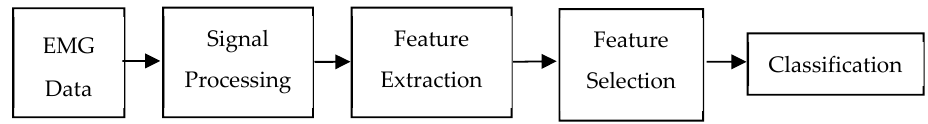
Figure 1. Flow diagram of the proposed electromyography (EMG) pattern recognition system.